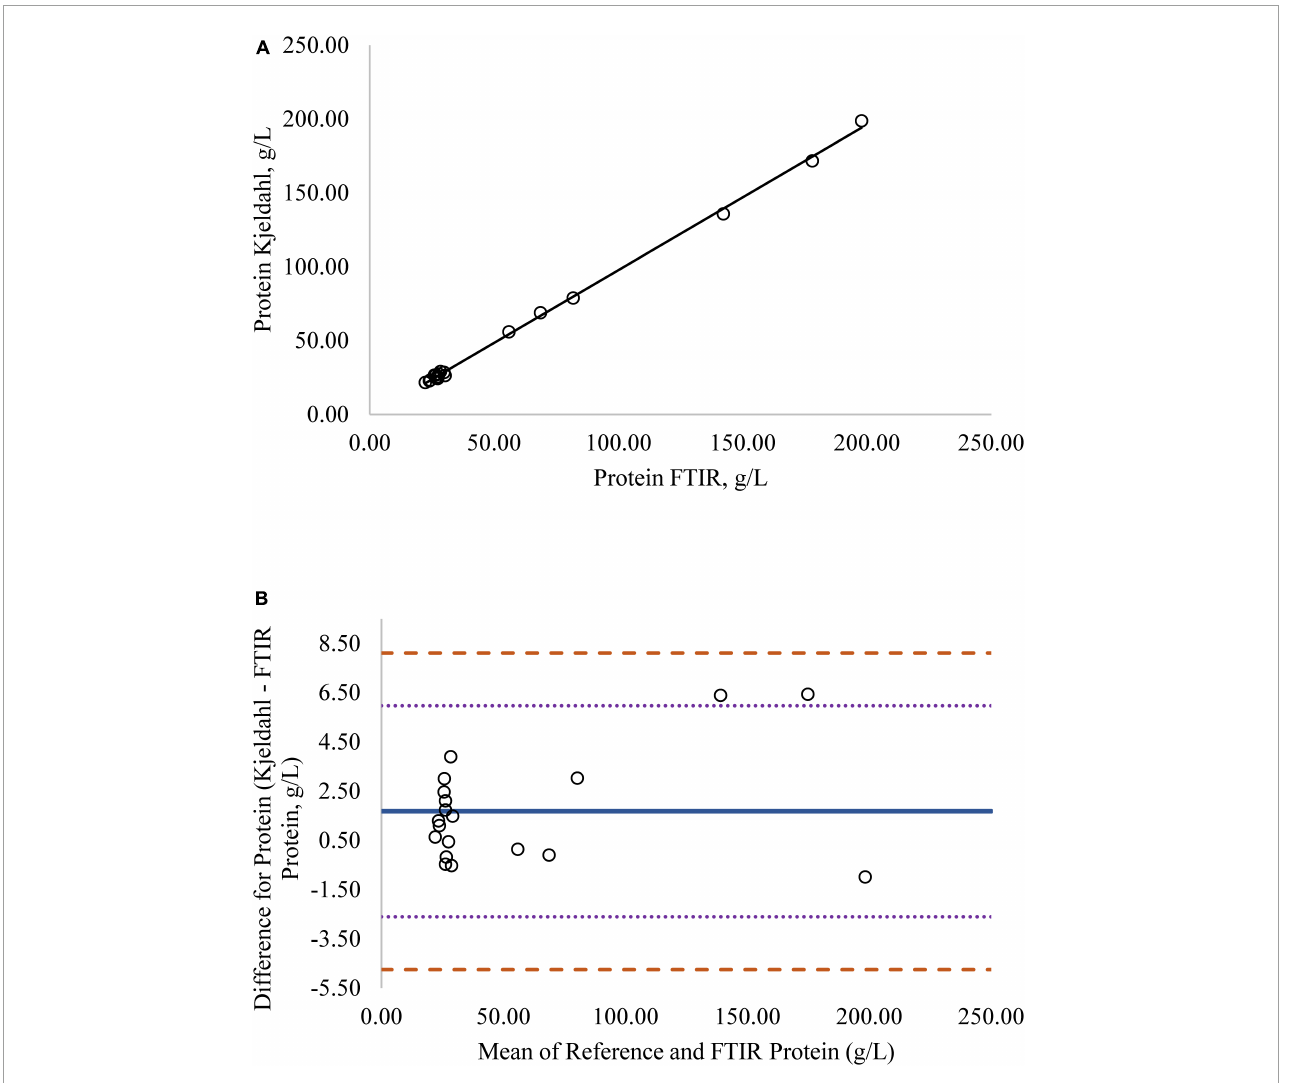
FIGURE1 (A) Mare milk protein concentration measured by Fourier transform infrared spectroscopy (FTIR) and the reference Kjeldahl method. Correlation graph between the two methods for protein, r 2 = 0.99, P < 0.0001. Regression model y = 0.986X – 0.088. (B) Mare milk protein concentration measured by FTIR and Kjeldahl method. Bland-Altman plot showing the mean differences and limits of agreement. Bias line: solid line, two standard deviation (s.d.): dotted lines, three s.d.: dashed